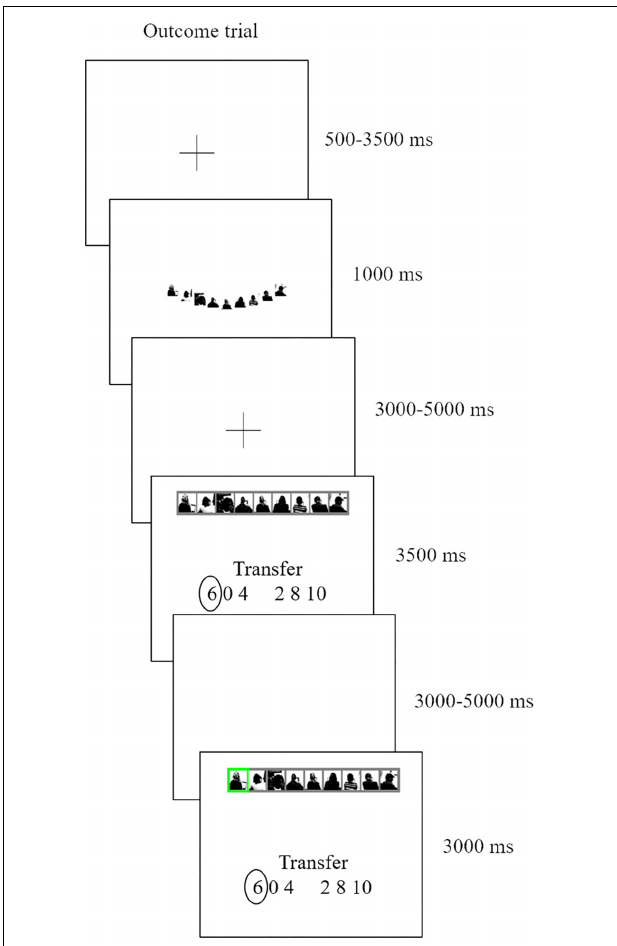
FIGURE 2 | An outcome of an ATG trial. We took pictures of receivers while they were seated behind a laptop. The pictures only show receivers’ silhouettes in black and white and no facial features are